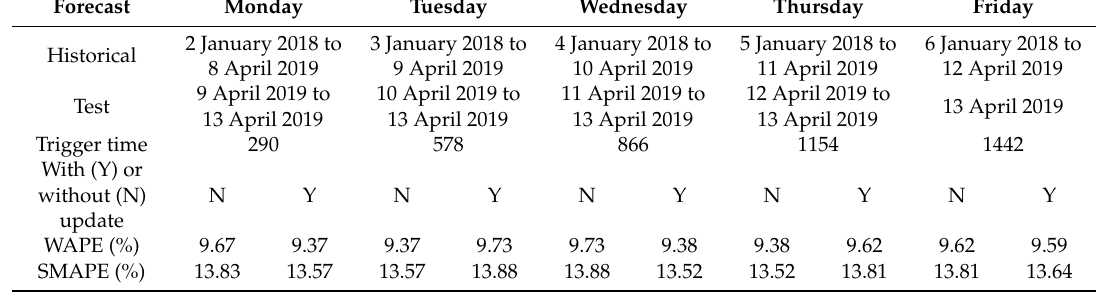
Table 2. Forecast result errors for each train.